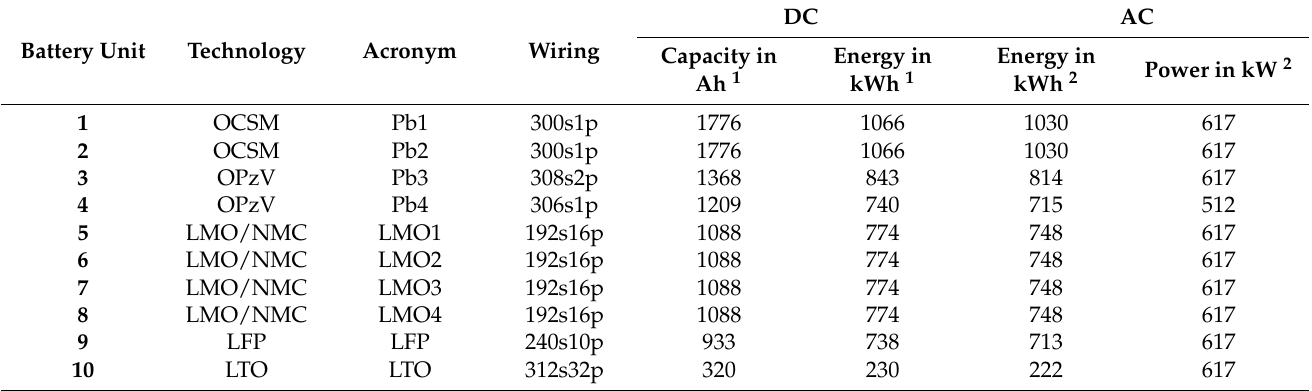
Table 2. Technical information on the different battery units and technologies